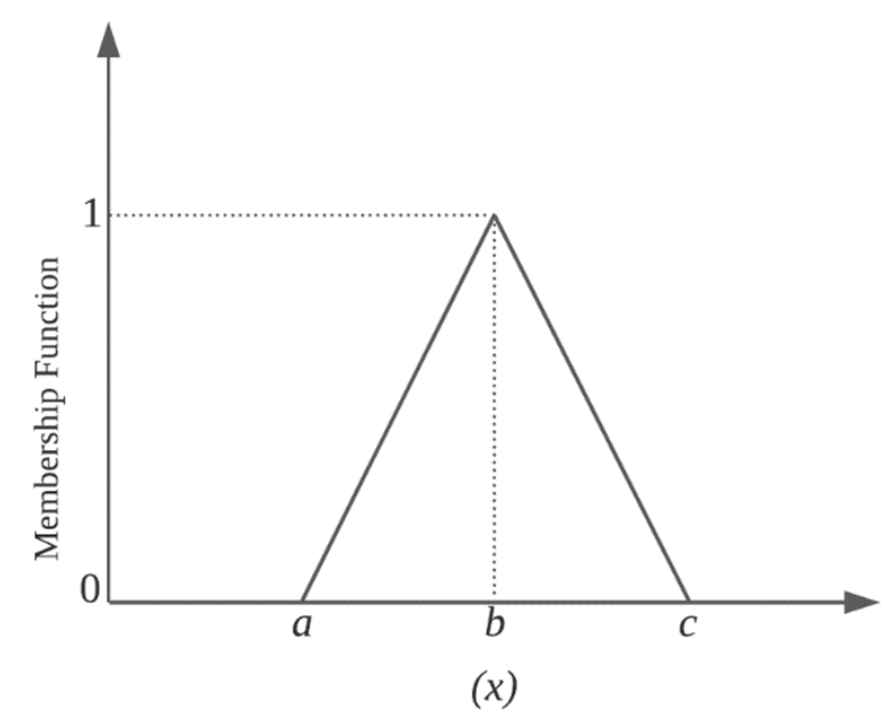
Figure 1. A common membership function of an FL system.